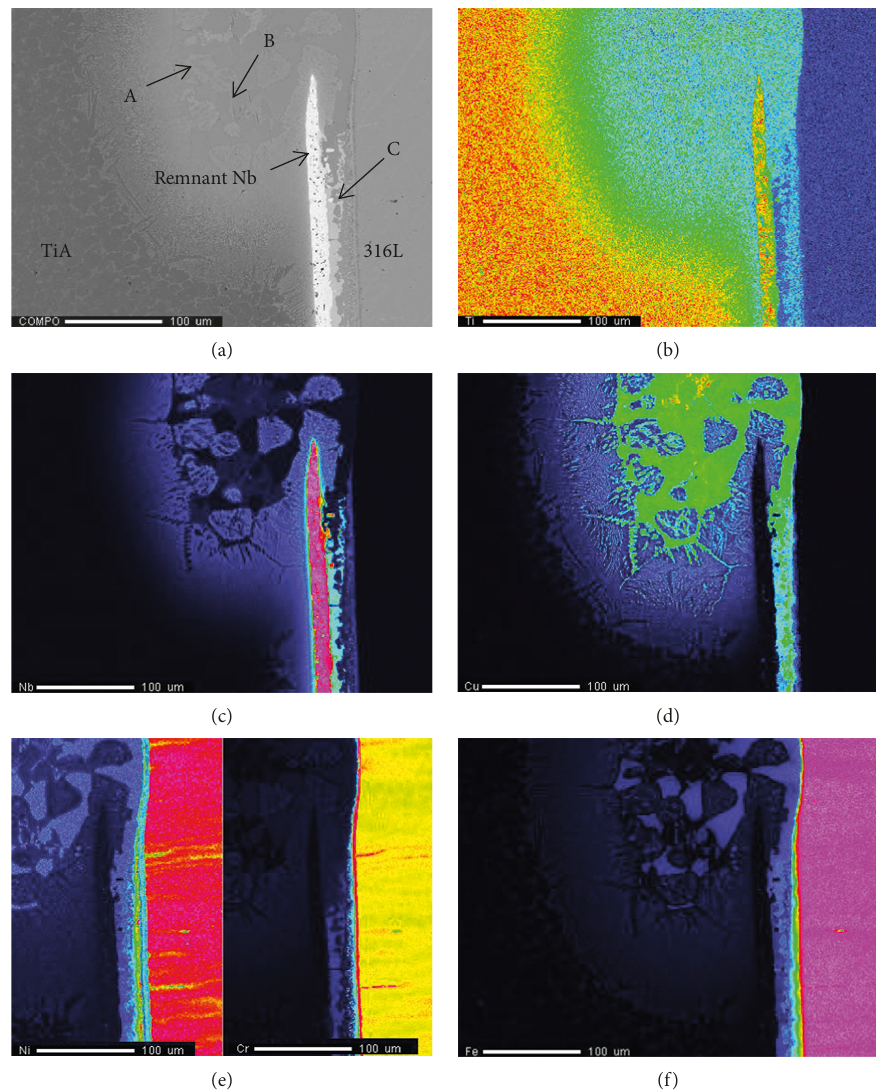
Figure 9: Concentration profiles from EPMA analysis of elements Ti, Nb, Cu, Ni, Cr, and Fe along with a BSE image of a region at Ti-6Al-4V and 316L joint interface bonded at 950 ° C: (a) BSE image; (b) Ti map; (c) Nb map; (d) Cu map; (e) Ni and Cr map; (f) Fe